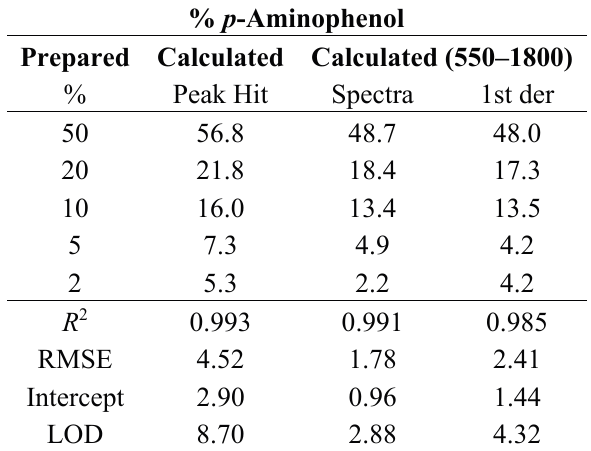
Table 1. Prepared and Calculated percentages of p -aminophenol mixed with acetaminophen determined using Raman peak height at 846 cm − 1 and spectral weighting of the spectra and their first derivatives for the 550 to 1800 cm − 1 region.